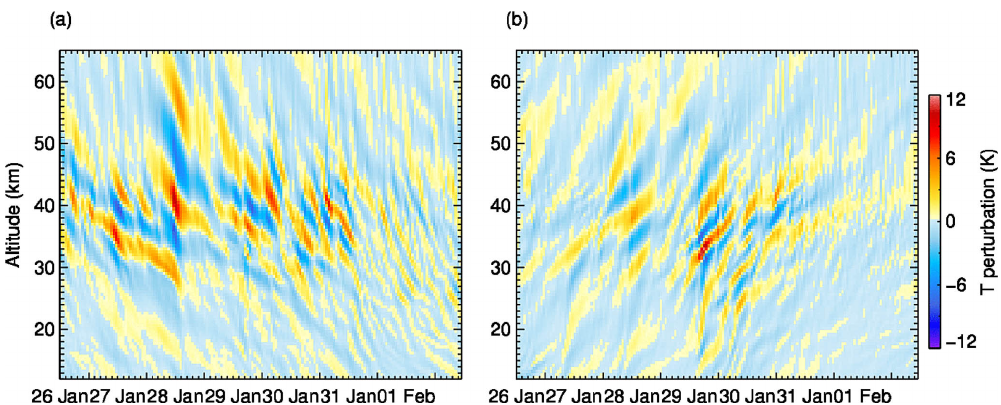
Figure 8. Temperature fluctuations associated with (a) upward- and (b) downward-propagating gravity waves as reconstructed by wavelet analysis (see